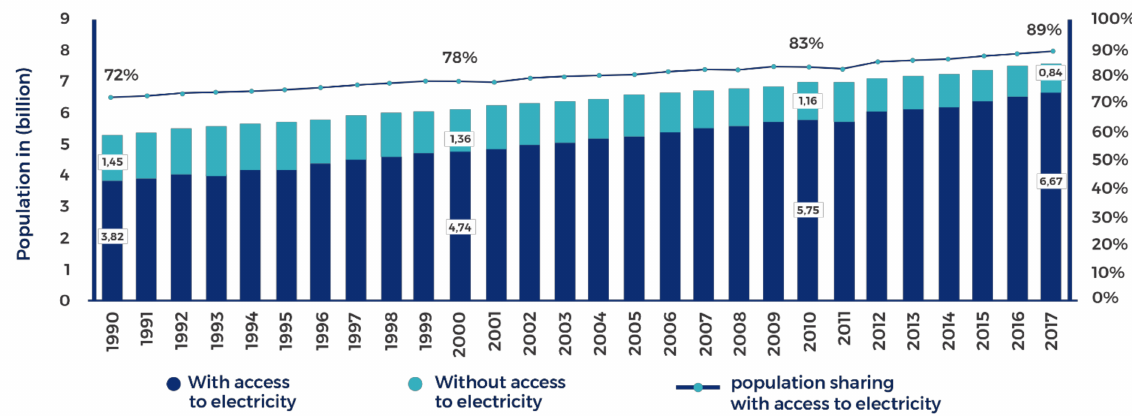
Figure 2. Evolution of the population over the years with and without access to electricity. Source: Based on IEA